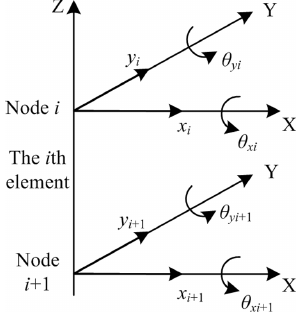
Fig. 4. Schematic diagram of (a) k 0 + Ψ( z ) , c 0 + Ψ c ( z ) vs. z and (b) λ ( z / c 1 ) vs. z / c 1